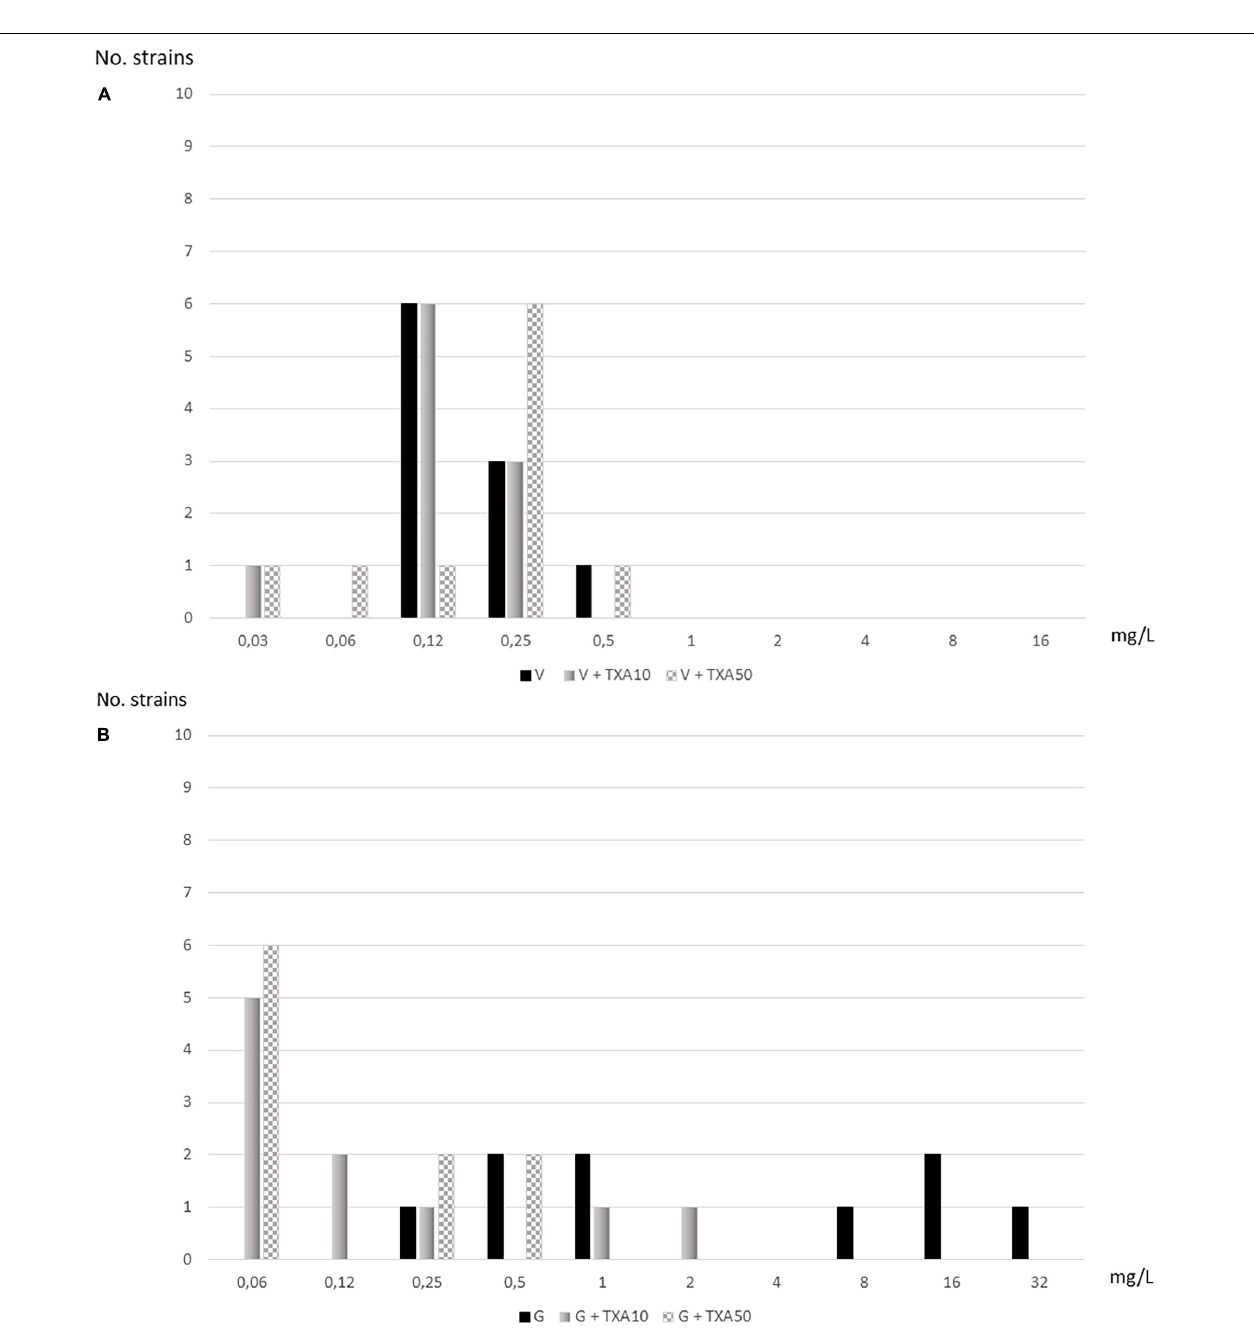
FIGURE 2 | Distribution of strains according to serial dilutions of vancomycin and gentamicin alone and in combination with tranexamic acid (TXA) using the standard visualization method. (A) Vancomycin. (B) Gentamicin.